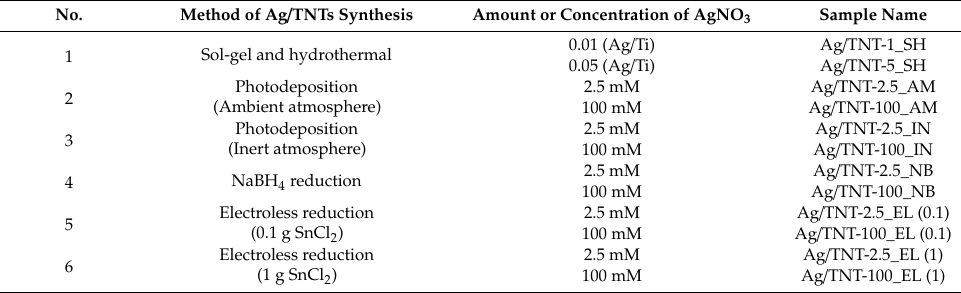
Table 1. Summarizes the applied methods of Ag / titanate nanotube (TNT) synthesis, the corresponding concentrations of AgNO 3 , and samples